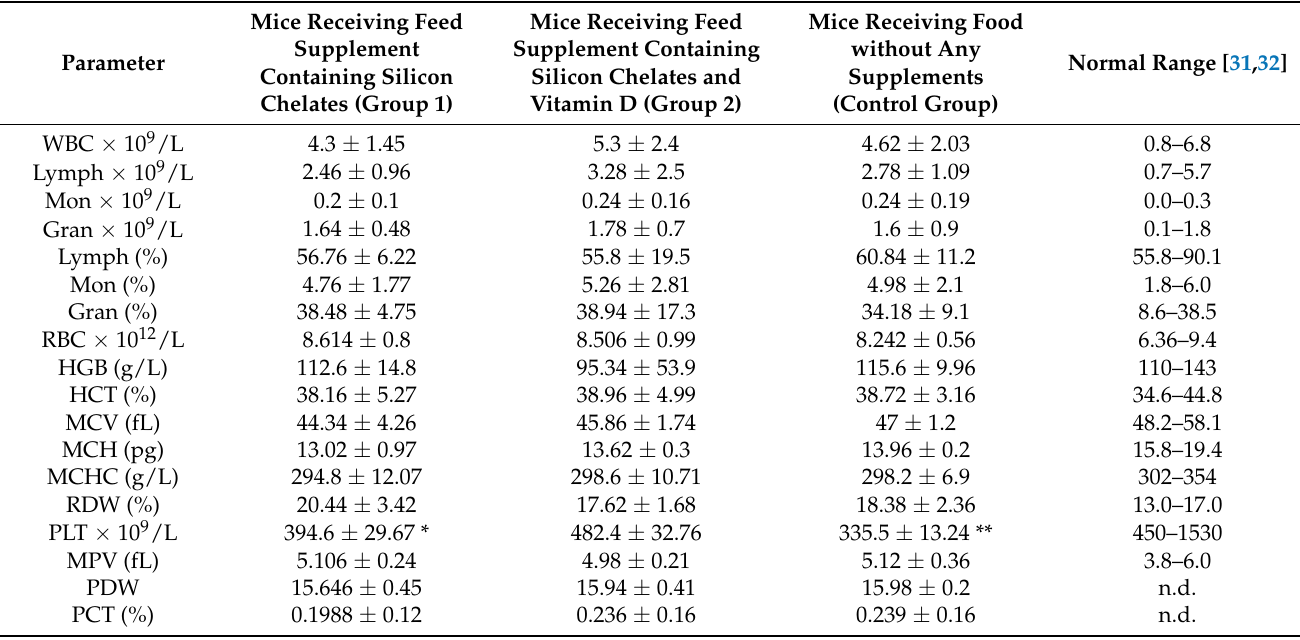
Table 5. The blood morphology parameters of ICR mice receiving feed supplements based on chelated silicon and vitamin D upon physiological bone decalcification.